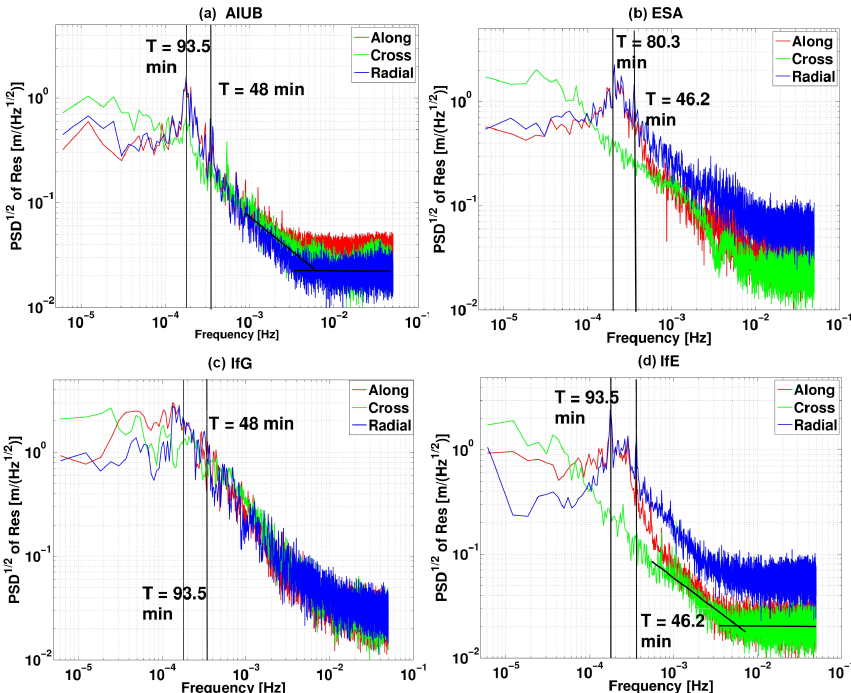
Figure 12. Spectral analysis of Swarm C orbits from and (a) AIUB, (b) ESA, (c) IfG and (d) IfE in March 2016. Slope 0 represents white noise and slope − 1 flicker noise.